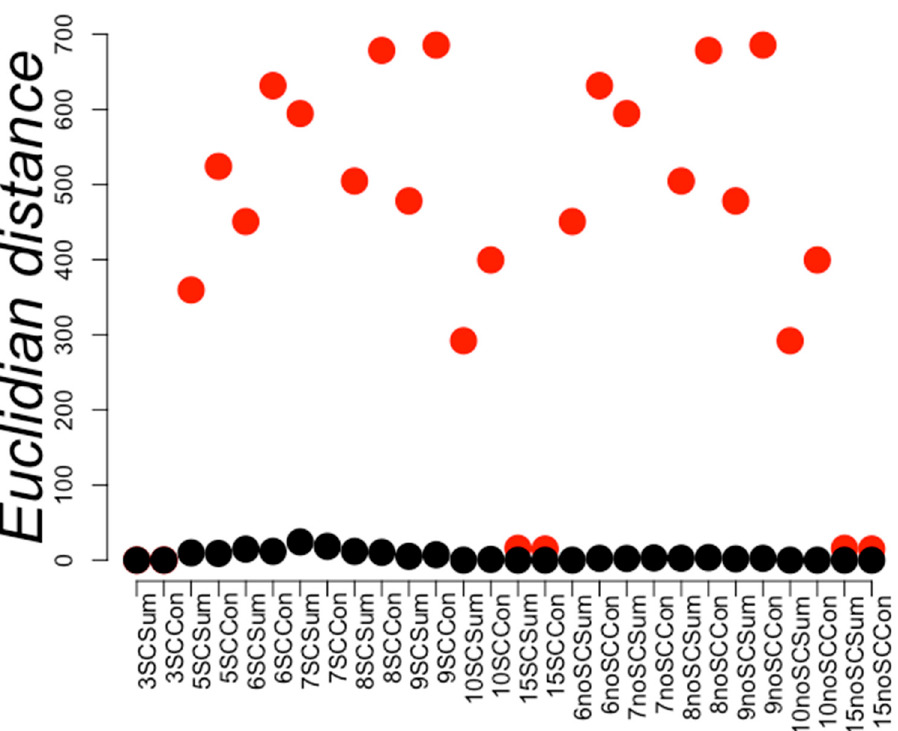
Figure 3. Distance within and between positive and negative PPI sets. Red circles represent the maximum Euclidian distances between instances of the same class (in this case, negative PPI) and the smallest distances between instances of different classes are shown in black circles. The Y -axis displays the distance values while the X -axis represents the different compared PPI representation compared. The first digit represents the distance used to build the RCCs and the next characters indicate whether the sidechains were included (SC) or not (noSC). Sum or Con indicates if the PPI was represented by the sum or concatenation of the individual RCC of the considered protein pair (see Methods). A red circle below the corresponding black circle indicates the separation of the positive PPI by distance from a negative PPI.